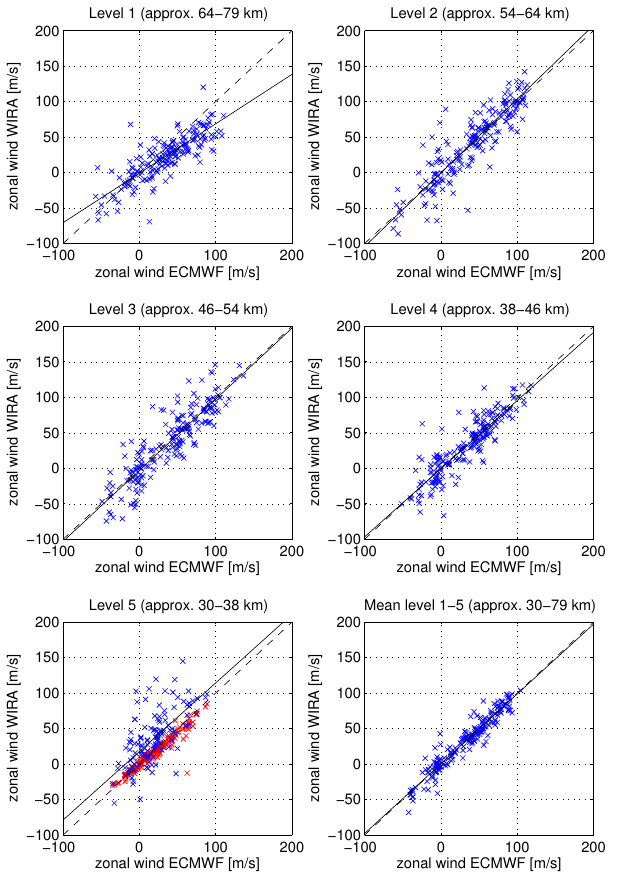
Fig. 13. Scatter plots between daily average WIRA winds retrieved with the mirror method and the ECMWF operational analysis data for the standard WIRA levels and the mean over these altitude ranges for the measurement period between 1 September 2010 and 31 July 2011. The solid black line is the fit through the data weighted with 1 /σ 2 whereas the dashed line represents identity. The red markers in the panel for level 5 represent the data from the radiosondes from Payerne that reached the lower pressure limit of this level.